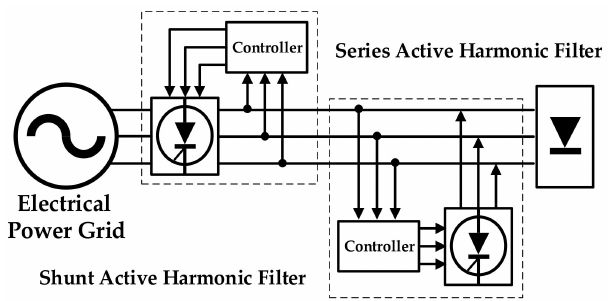
Figure 1. Schematics of the shunt and series active harmonic